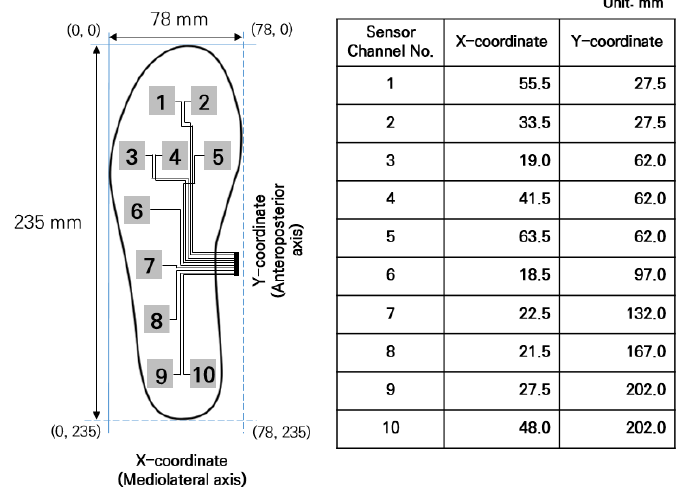
Figure 4. Coordinate information detected by each sensor channel of I-TCPs.